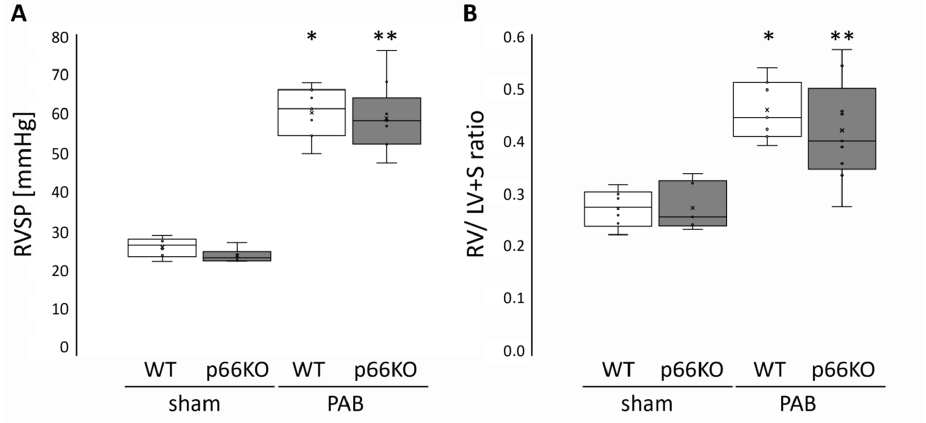
Figure 2. Right ventricular systolic pressure (RVSP) and hypertrophy in mice three weeks after pulmonary artery banding (PAB) or sham surgery. ( A ) RVSP (in mmHg) and ( B ) right ventricular weight normalized to the left ventricle and septum weight (RV/LV + S ratio). Data are given for wild type (WT) and p66shc knockout (p66KO) mice three weeks after sham surgery ( n = 6 each group) and for WT and p66KO mice three weeks after PAB (n = 7 and n = 9, respectively). Data are expressed as 25%, 50%, and 75% quartiles with whiskers representing the total range. The dots represent the individual data points. *: p < 0.05 vs. WT sham and **: p < 0.05 vs. p66KO sham as analyzed by two-way ANOVA. Table 3. Right ventricular weight and ventricular geometry in mice three weeks after pulmonary artery banding (PAB) or sham surgery. Data show the right ventricular weight normalized to body weight (RV/BW in mg/g), the right ventricular wall thickness (RVWT in mm) and the right ventricular inner diameter (RVID in mm). Data are given for wild type (WT) and p66shc knockout (p66KO) mice three weeks after sham surgery ( n = 6 each group) and for WT and p66KO mice three weeks after PAB ( n = 7 and n = 9, respectively). Data are shown as means ± SD. *: p < 0.05 vs. WT sham and **: p < 0.05 vs. p66KO sham as analyzed by two-way ANOVA.